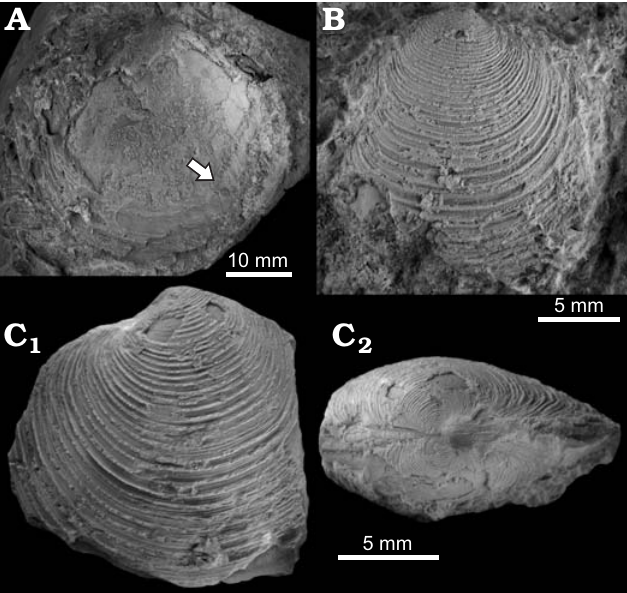
Fig. 5. The lucinid Lucinoma zapotalensis (Olsson, 1931) from early Oligocene seep deposit at Cerro La Salina (block 1, C; block 9, A) and Cerros El Pelado (block 2, B), Talara Basin, northern Peru. A . Internal mold of large left valve (NRM Mo187011), left valve showing anterior adductor muscle scar (arrow). B . NRM Mo187012, external sculpture on right valve. C . Articulated specimen (NRM Mo187013), showing external sculpture on left valve (C 1 ) and lunule and ligament in dorsal view (C 2